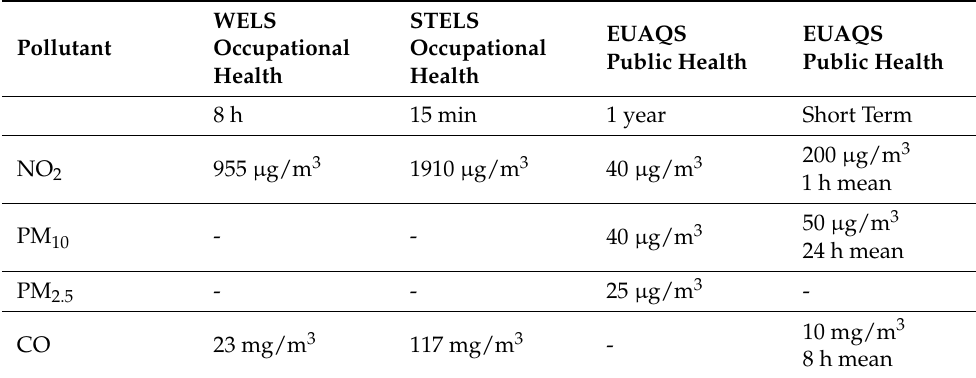
Table 1. Workplace Exposure Limits (WELS) and EU Air Quality Standards (EUAQS). WELS Pollutant Occupational Health